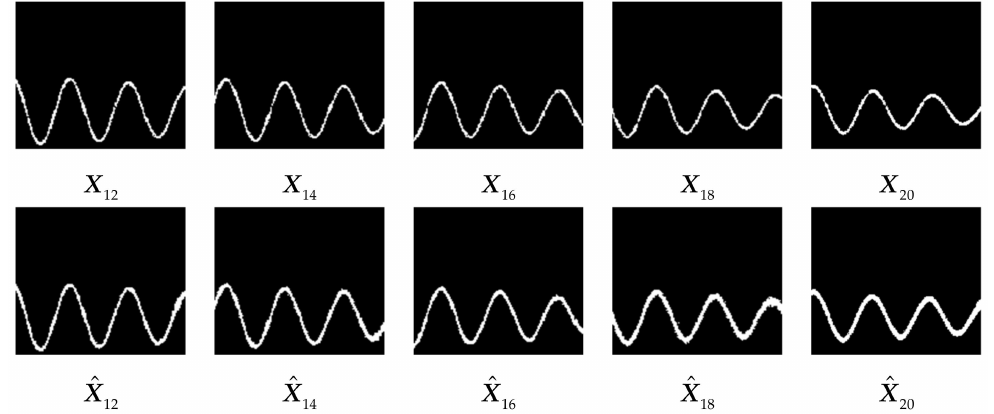
Figure 6. The prediction results for SM-WBI. The first row shows the ground truth and the second row shows the predicted results.